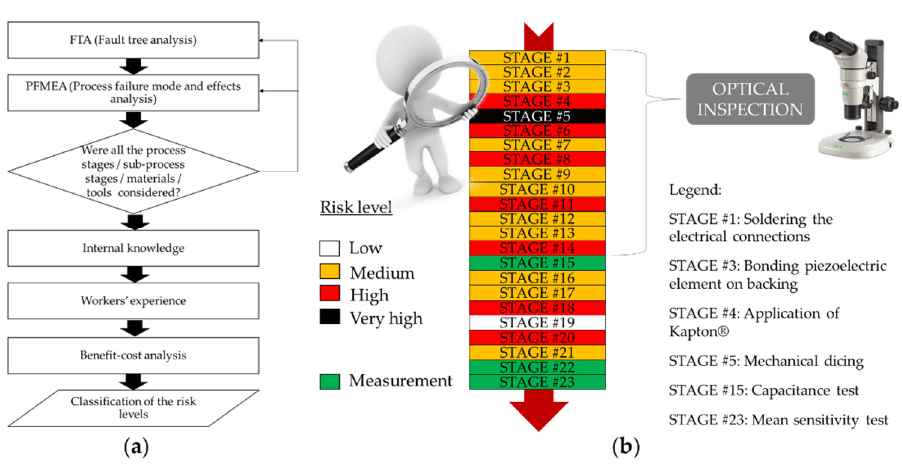
Figure 3. High definition of the process. ( a ) Risk level classification flowchart; ( b ) risk level assign-